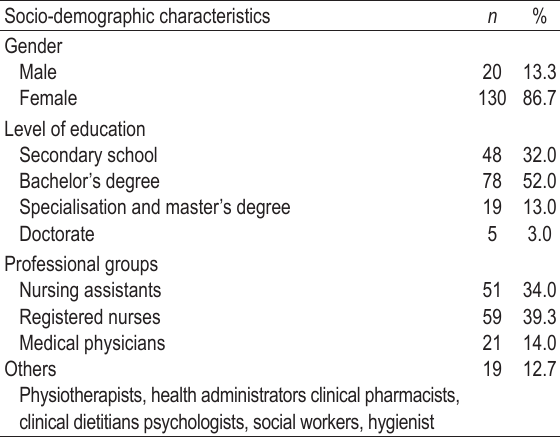
TABLE 1. Socio‑demographic characteristics of sample ( n